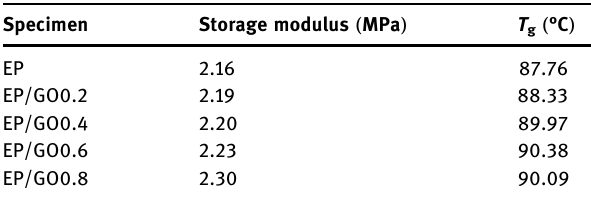
Table 1: Dynamic mechanical properties of neat epoxy and the EP/ GO at 25°C